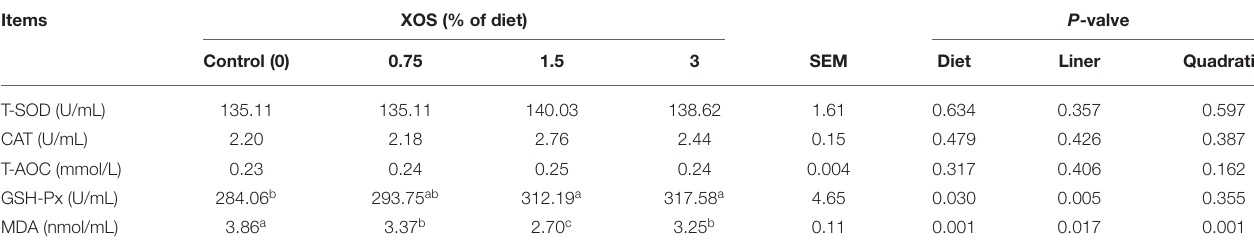
TABLE 5 | The effects of XOS supplementation on antioxidant activities of weaning piglets. Items